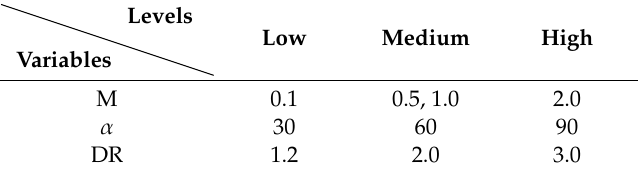
Table 3. Levels of the independent variables used in the response surface methodology